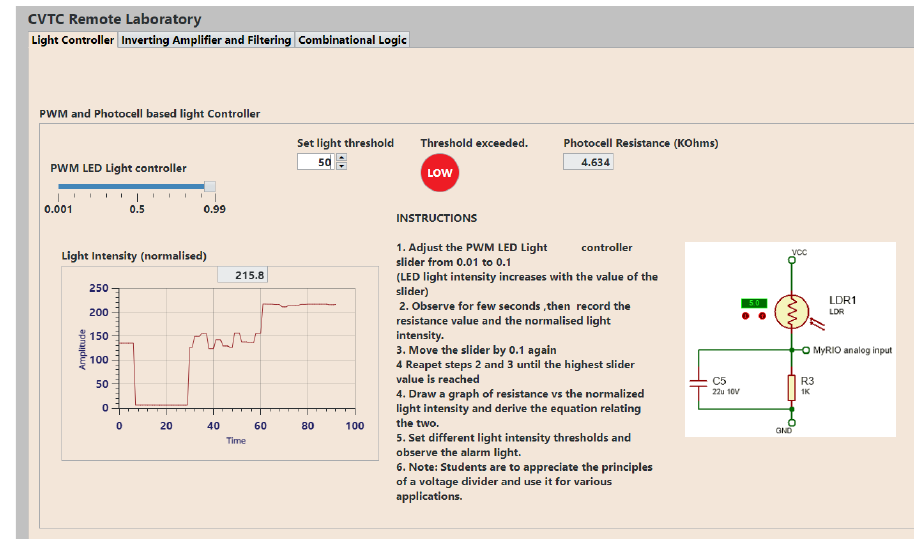
Figure 10. Photocell and Thermistor laboratory interface.